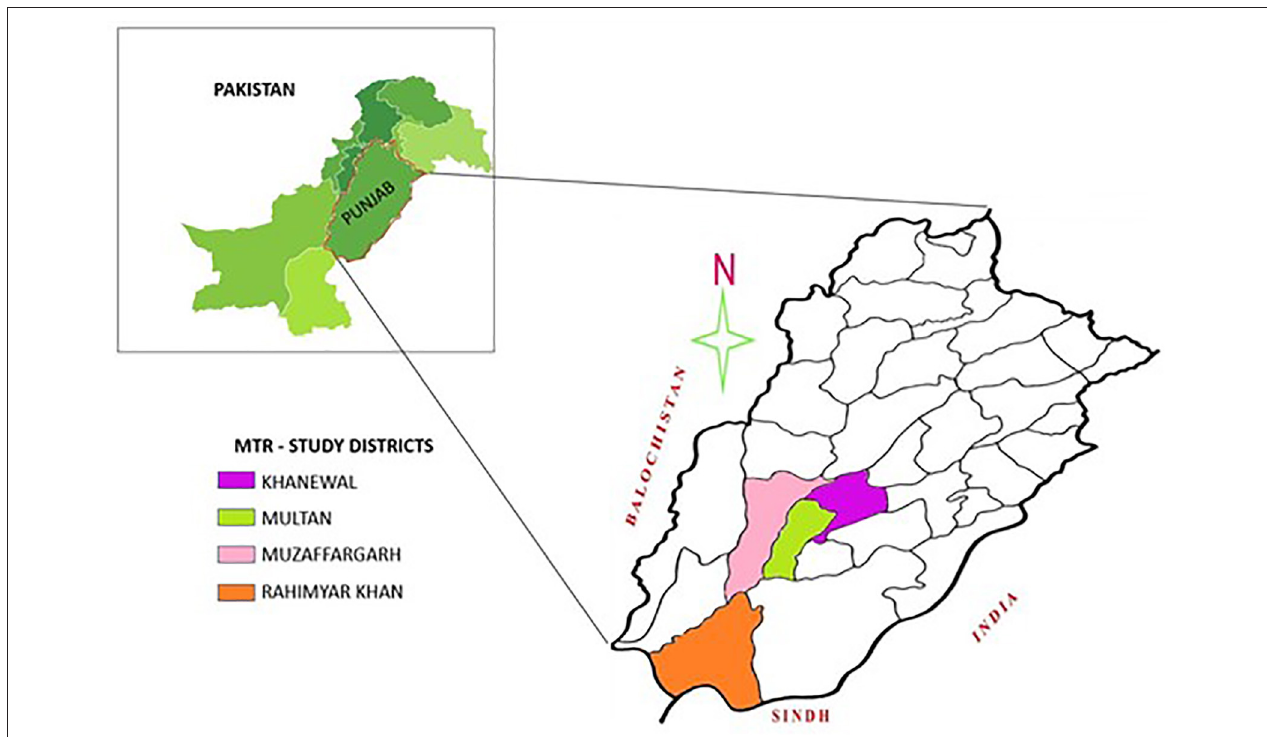
FIGURE 1 | Map of the study